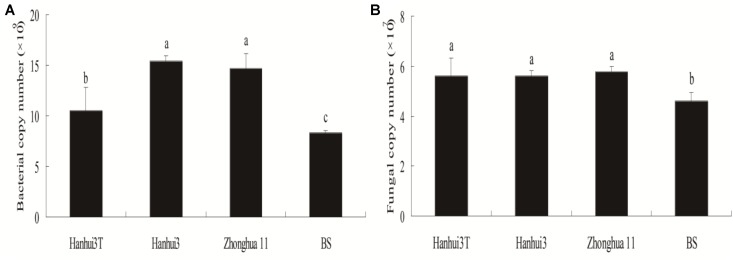
Copy numbers of the 16S rRNA (A) and ITS (B) genes from the rhizosphere microbial DNA extracts (Mean ± Standard Deviation) as determined by qPCR. BS indicates bulk soil control.